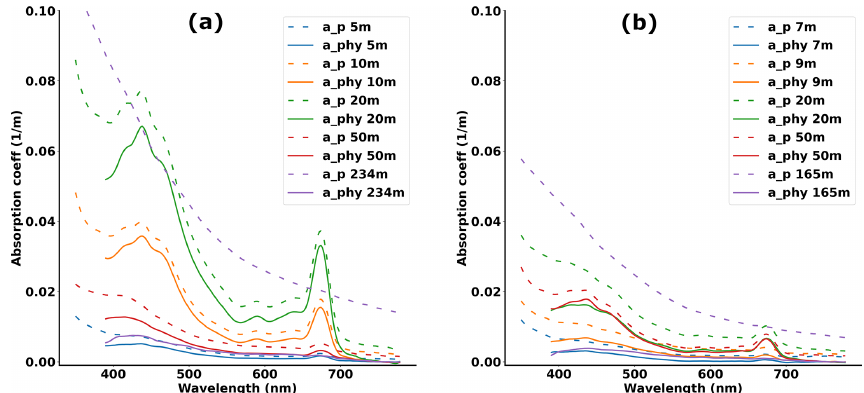
Figure 9. Comparison of total particulate a p (dashed line) and phytoplankton a phy (solid line) absorption in Storfjordrenna at station 501 (a) and in the fjord north of the sill at station 508 (b) with depth. Table 1. Average values of the main water IOPs for the five cases corresponding to northern surface (NSurf), southern surface (SSurf), northern subsurface (NSub), southern subsurface (SSub), and dense bottom water (Bott). The number of samples n is given for the water- sample-based quantities and does not apply to b 440 /a 440 , which comes from the ac-s data. n a cdom 440 S cdom